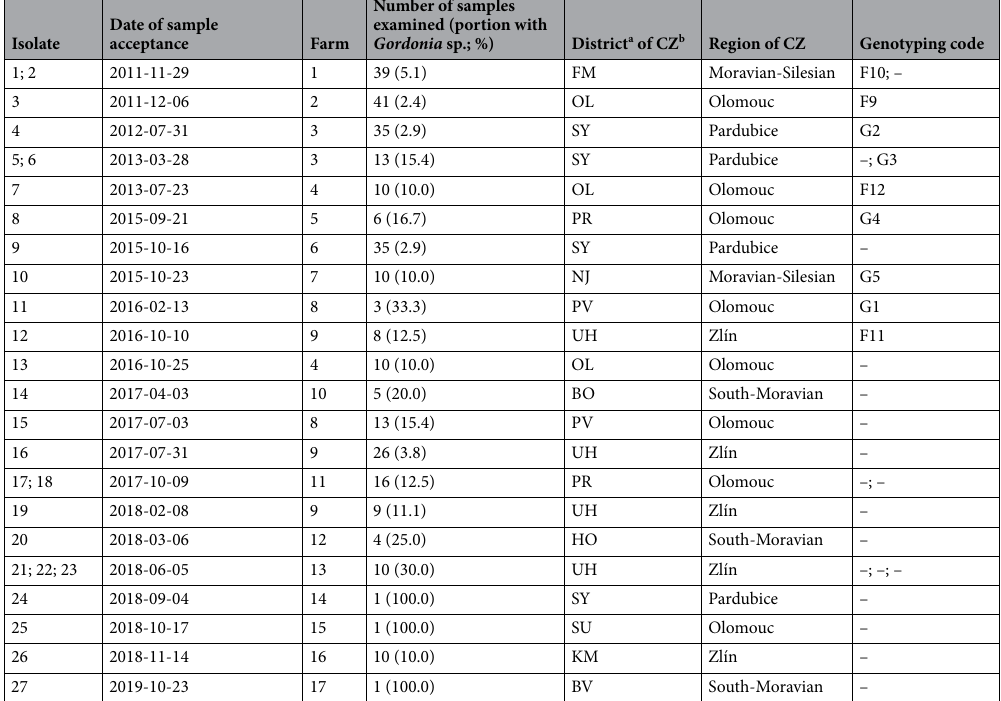
Table 1. Anamnestic data for Gordonia sp. isolates (n = 27) from mastitis milk of dairy cows. a Official abbreviation of the district name; b CZ = Czech Republic.